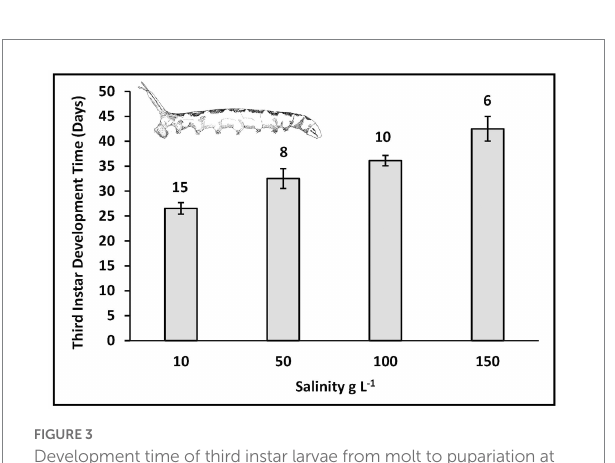
FIGURE 3 Development time of third instar larvae from molt to pupariation at varied salinities of Mono Lake water. Number of larvae tracked to pupariation, and standard errors for each